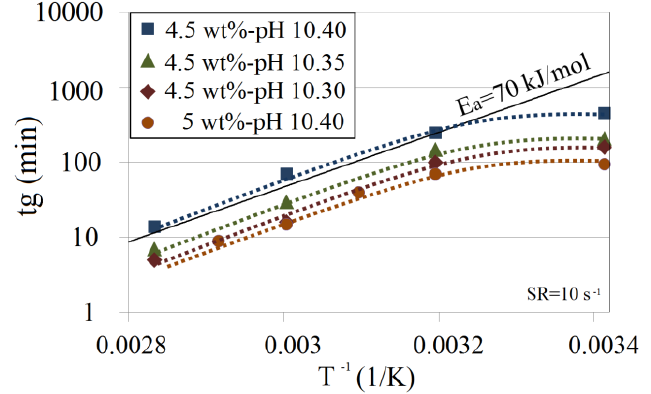
Figure 7. Gelation time as a function of reciprocal absolute temperature for 4.5 wt% and 5 wt% Na-silicate solutions with different pH values. The solid line corresponds to the ≈ 70 Arrhenius equation with E a